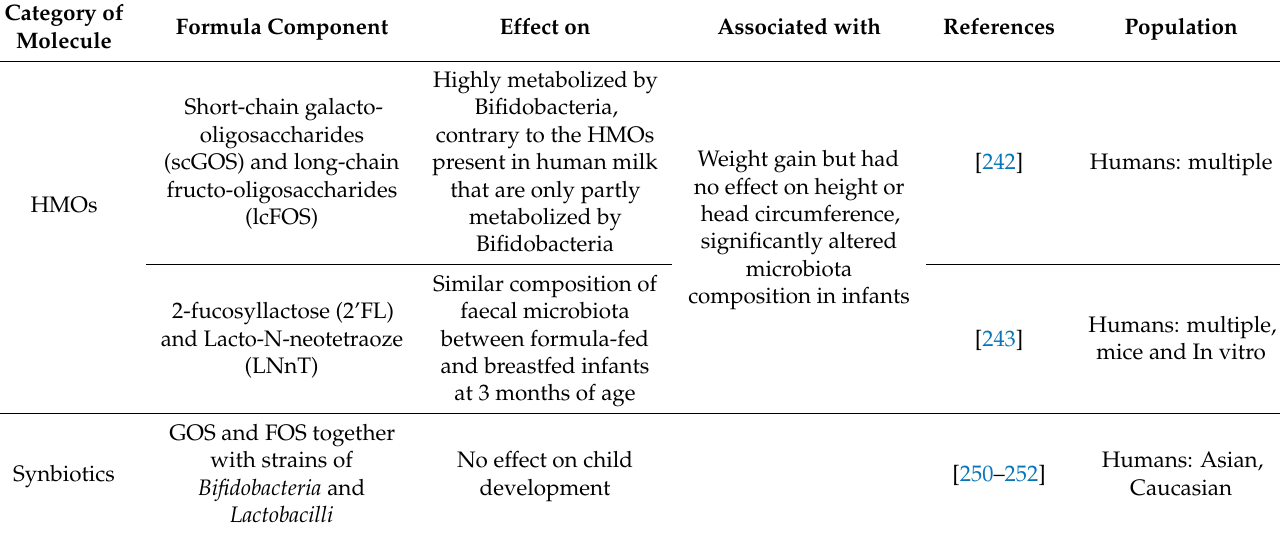
Table 5. Components of infant formula in order to simulate the synbiotic potential of human milk. Category of Formula Component Effect Molecule